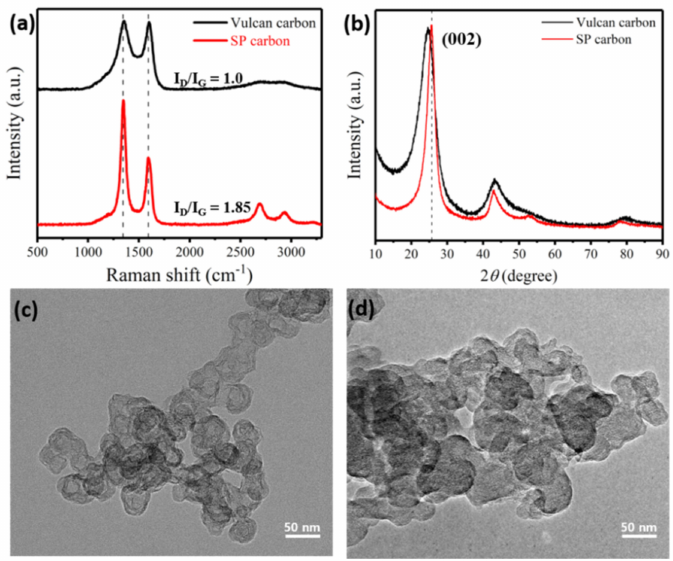
Figure 2. ( a ) Raman spectra and ( b ) XRD patterns of SP carbon and Vulcan XC-72. TEM images of ( c ) SP carbon and ( d ) Vulcan